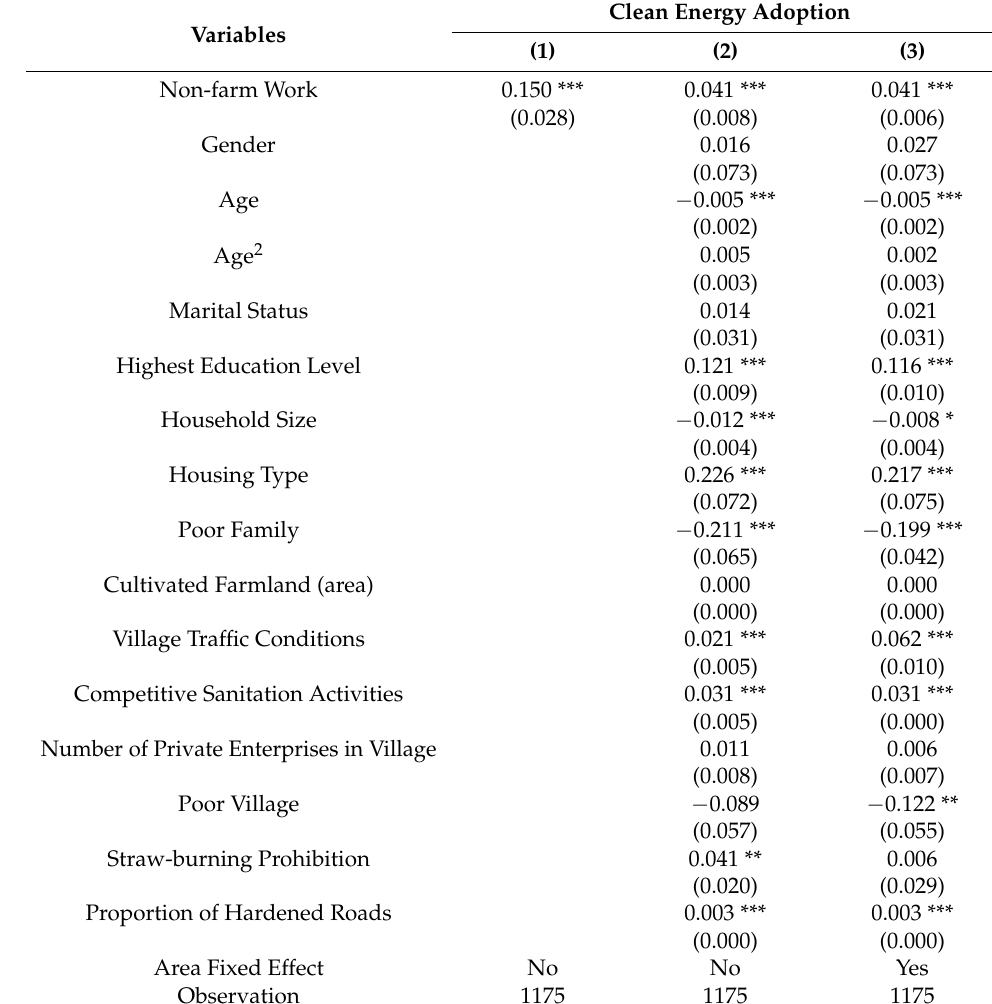
Table 2. Baseline Regression